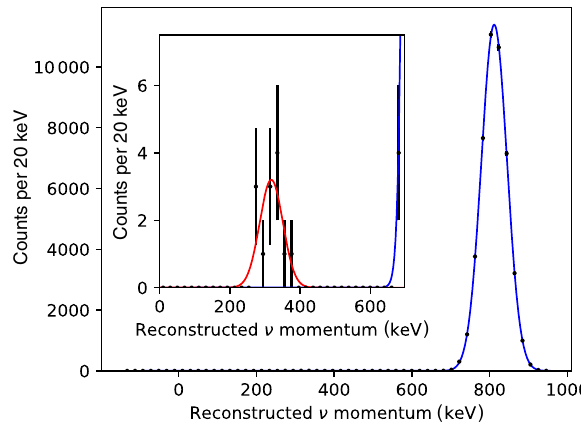
FIG. 2. The simulated spectrum for the reconstructed neutrino momentum, | p ν | , for a 100-nm-diameter nanosphere contain- ing 1% by mass of the EC-unstable isotope 37 Ar. We assume an exposure of 30 days and 40% collection efficiency for the emitted Auger e − or x ray. Also overlaid (and visible in the inset) is the expected spectrum arising for a heavier sterile state with m 4 = 750 keV and at the existing upper limits for a sterile ν at this mass, | U | 2 = 2 × 10 − 4 [15]. Backgrounds and mis- e 4 reconstructed events are not included in the simulation (for a detailed discussion of the required background rejection to meet this assumption, see Sec. III D). The black data points with error bars indicate the simulated counts for a typical experimental real- ization, along with the best fit to these data for decays to SM neutrinos (blue) and the heavier sterile state